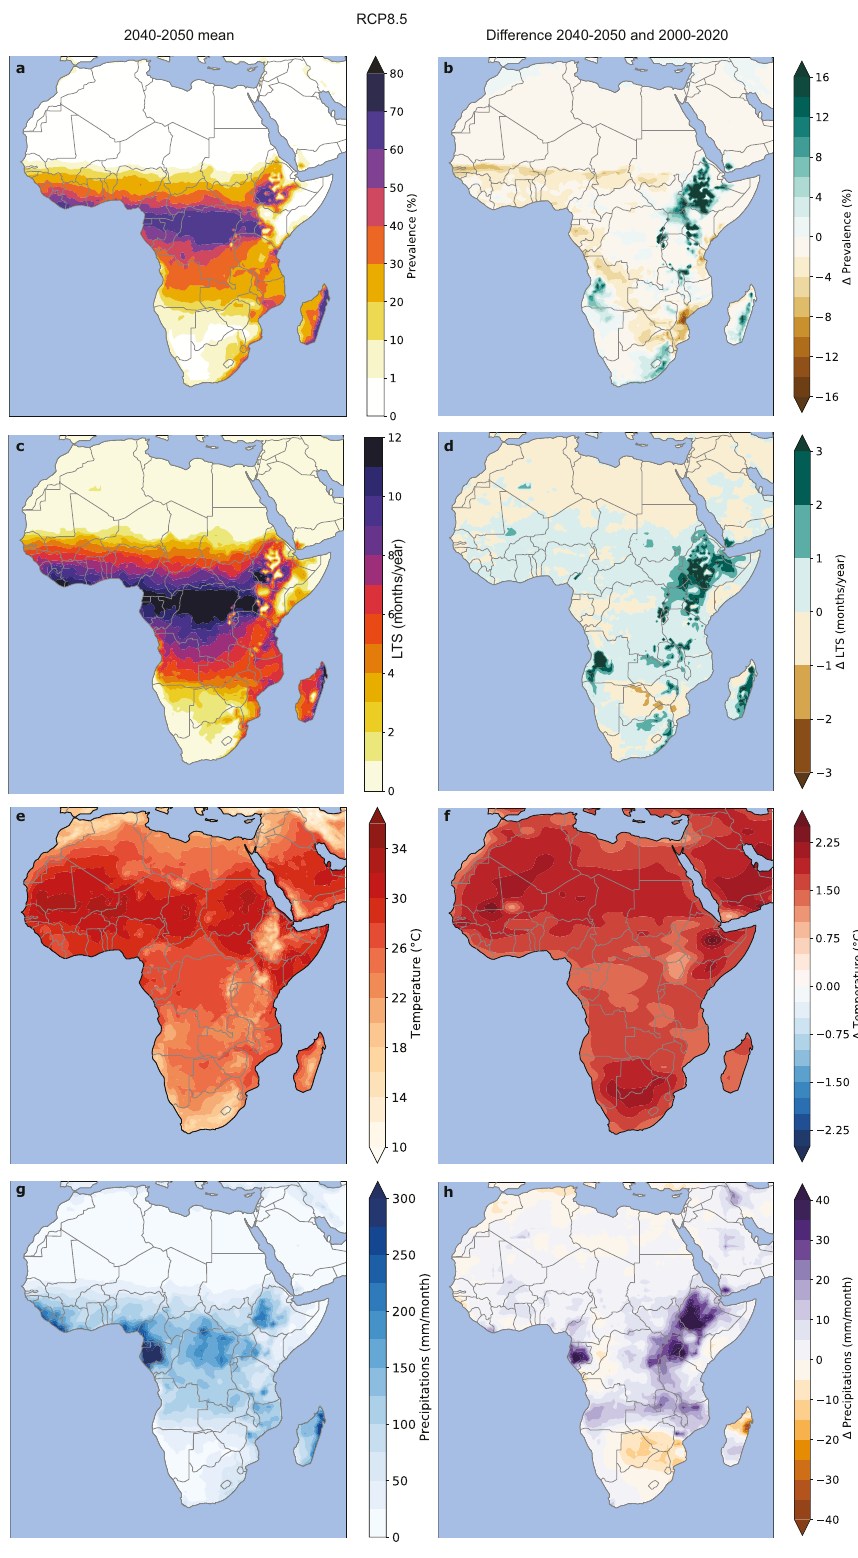
Fig. 2 Mean and future changes in climate parameters and malaria risk based on the RCP8.5 scenario. The left-hand column ( a – c – e – g ) depicts mean patterns for the 2040s and the right-hand column ( b – d – f – h ) shows future differences between the 2040s and 2010s. a , b malaria prevalence (%) simulated by the LMM, c , d LTS (in months) based on the MARA model. e , f temperature (°C) and g , h precipitation (mm.month − 1